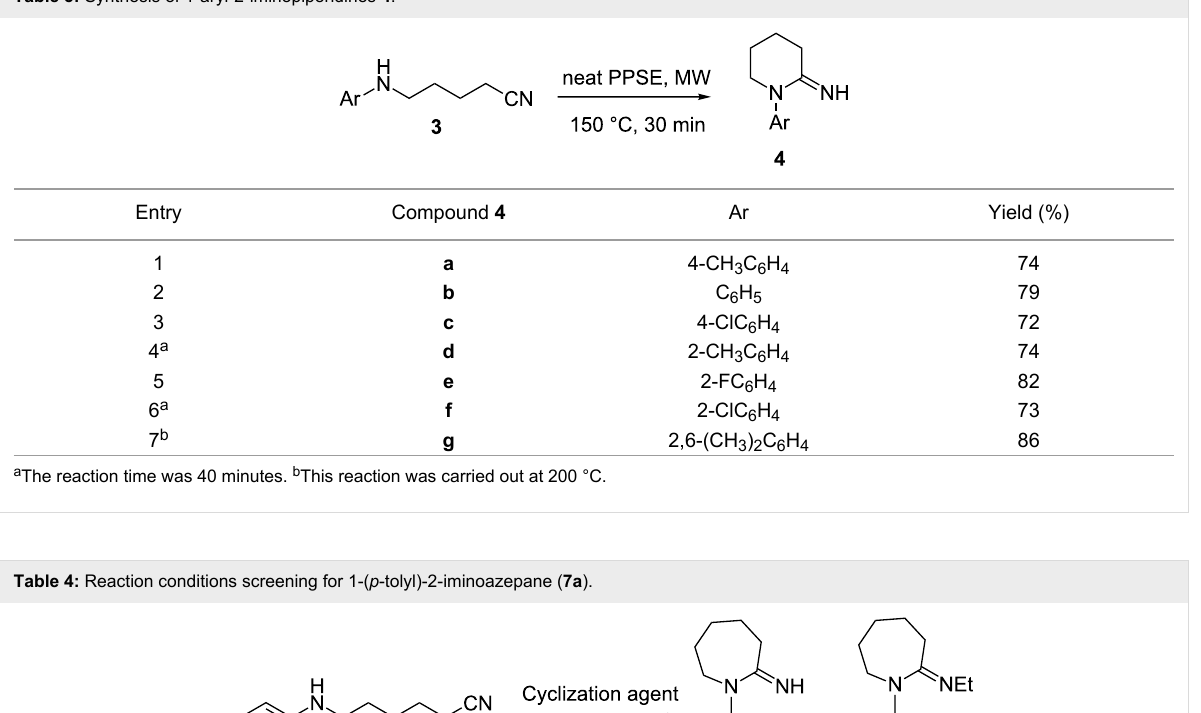
Table 3: Synthesis of 1-aryl-2-iminopiperidines 4 .